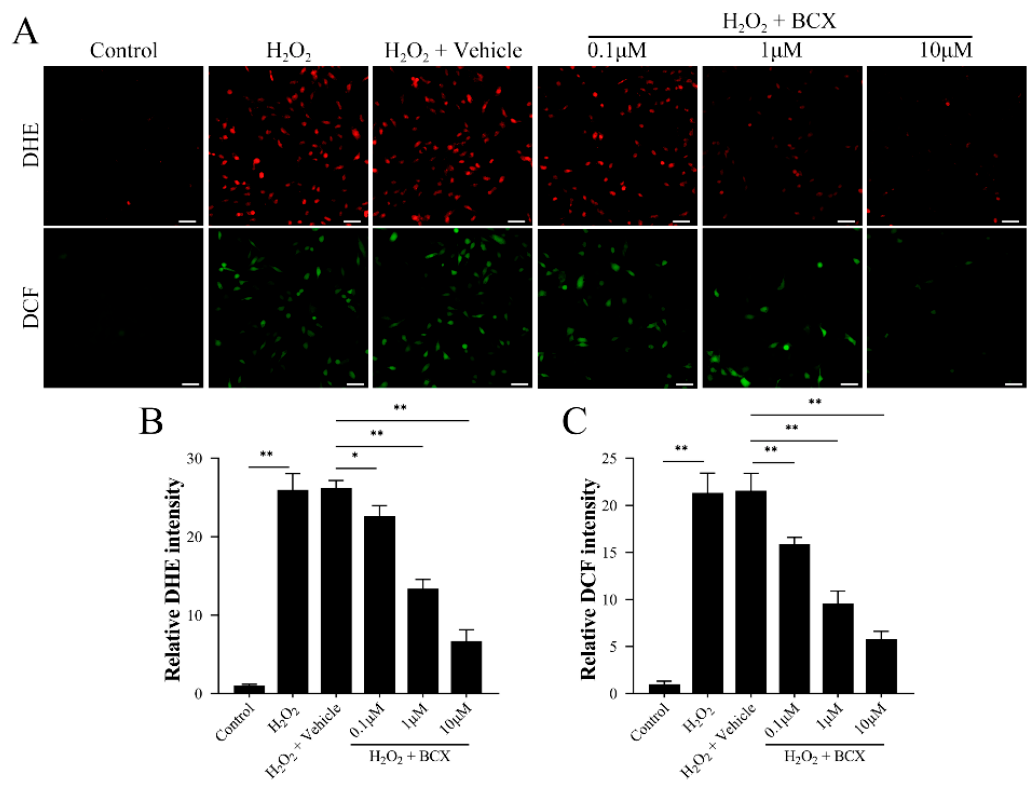
Figure 3. BCX significantly suppressed H 2 O 2 -induced oxidative stress in HK-2 cells. After pretreat- ment with different doses of BCX (0.1, 1 and 10 µM) for 24 h, HK-2 cells were treated with 800 µM H 2 O 2 for 48 h. ( A – C ) Levels of superoxide anion and reactive oxygen species in HK-2 cells were detected by DHE and DCF staining. Scale bar = 50 µm. Values are expressed as mean ± SD. The mean value is the average of the results of three replicate experiments. n = 3. * p < 0.05 and ** p < 0.01.